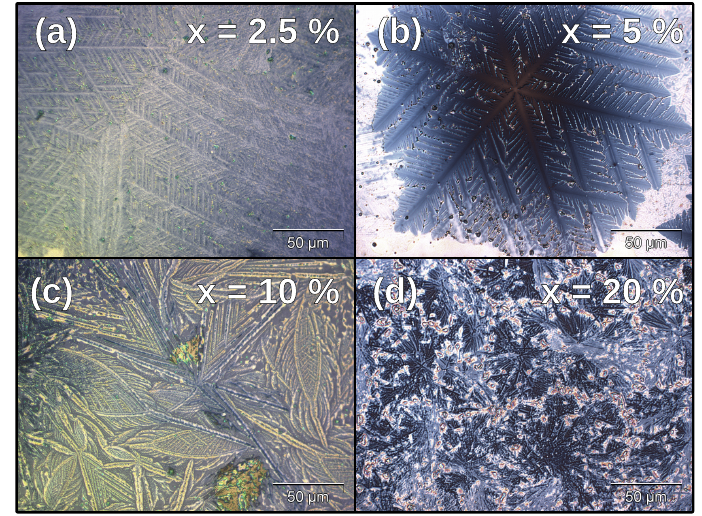
Figure 2. Optical microscopy pictures of SrCO 3 -containing Si 0.7 Ge 0.3 O 2 samples after annealing. ( a , b ) The growth was dendritic at low Sr content. ( c ) The formation of long needles. ( d ) Small, disorderly crystalline features. Images of the remainder of the concentration series are available in Figures S2 and S8 of the Supplementary